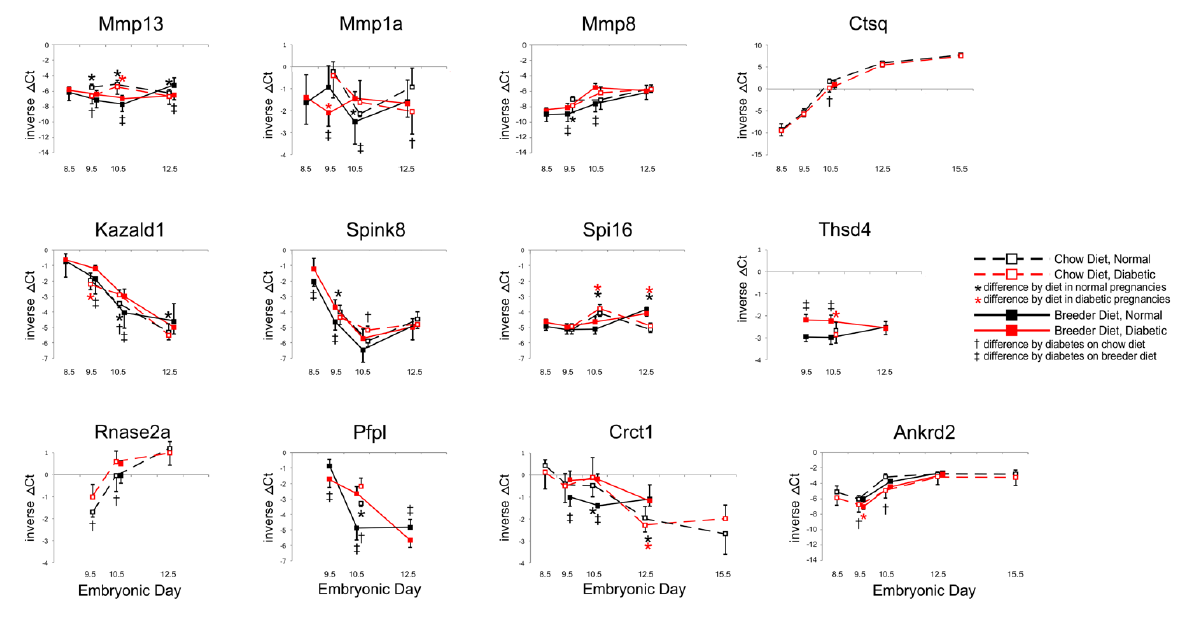
Figure 5. Expression of genes involved in inflammation, cell adhesion and migration. Quantitative PCR measurements were performed at various time points, in dams that were either fed chow or breeder diet, and became diabetic in the week before, or were normoglycemic at the time of mating.